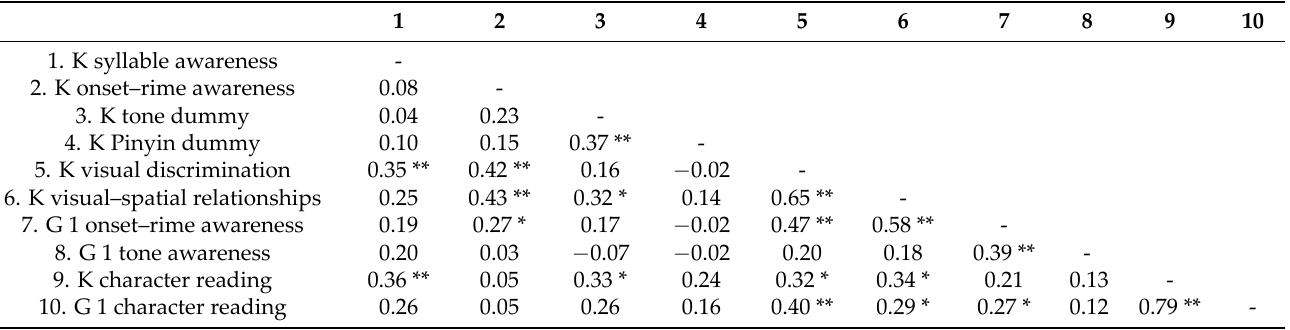
Table 2. Correlations for phonological awareness, Pinyin letter knowledge, visual perception skills, and Chinese character reading in kindergarten and first